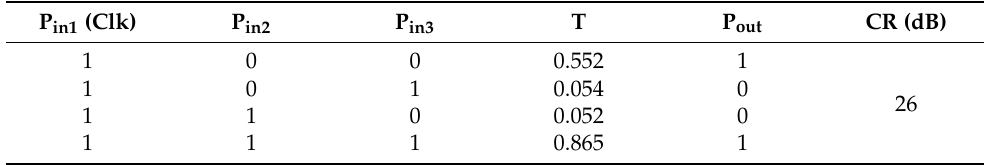
Table 8. Simulation findings for XNOR (T th = 0.14).